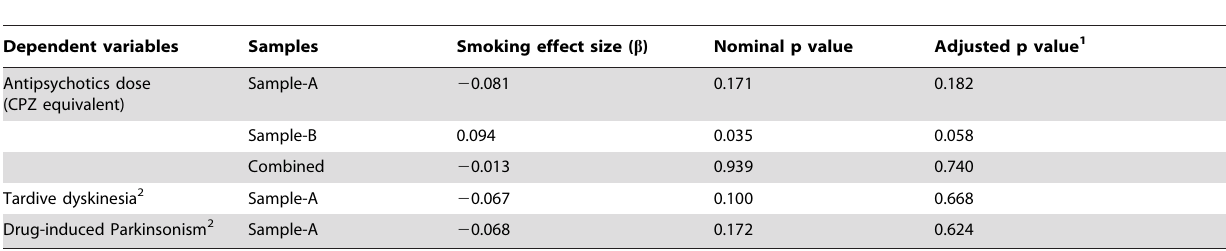
Table 3. Association of smoking with antipsychotics dose and EPS in regression